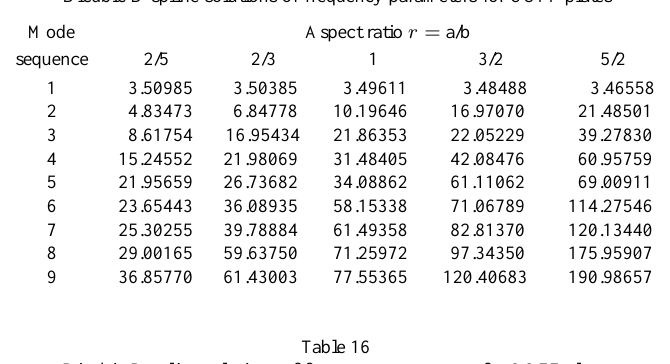
Table 15 Bicubic B-spline solutions of frequency parameters for CGFF plates